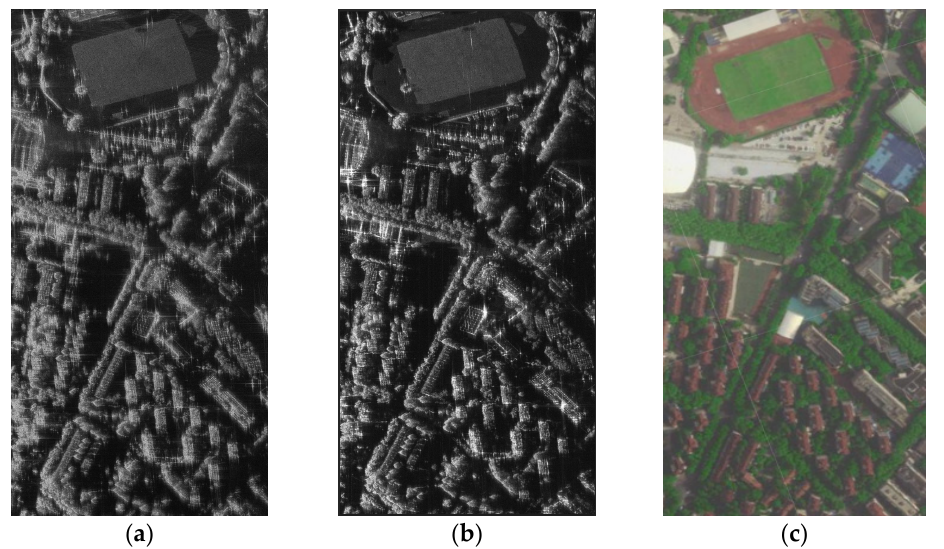
Figure 5. Image of FuDan University. ( a ) UAV-borne SAR image without auto focusing. ( b ) SAR image with auto focusing. ( c ) Google Earth optical image.